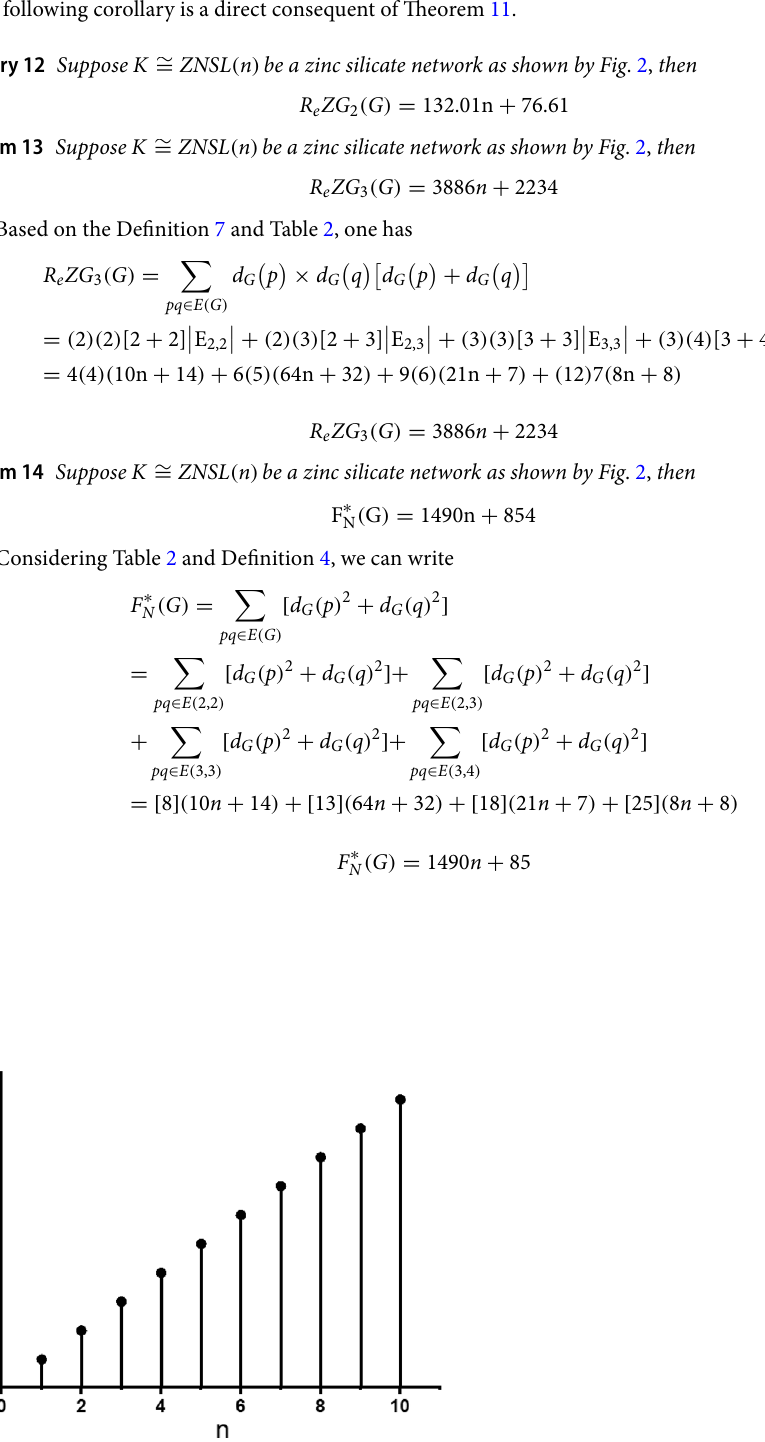
Figure 3. The comparison of n and M 2 ( G )